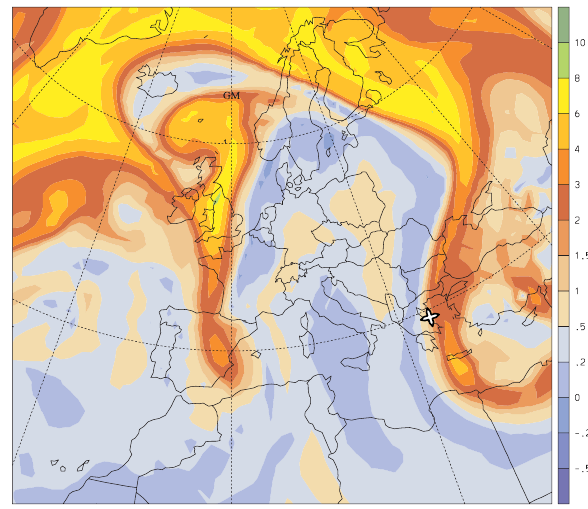
Fig. 3. Potential vorticity map in PV units on the 315K isentropic surface on 29 November 2000 at 18:00 UT (Thessaloniki is marked by